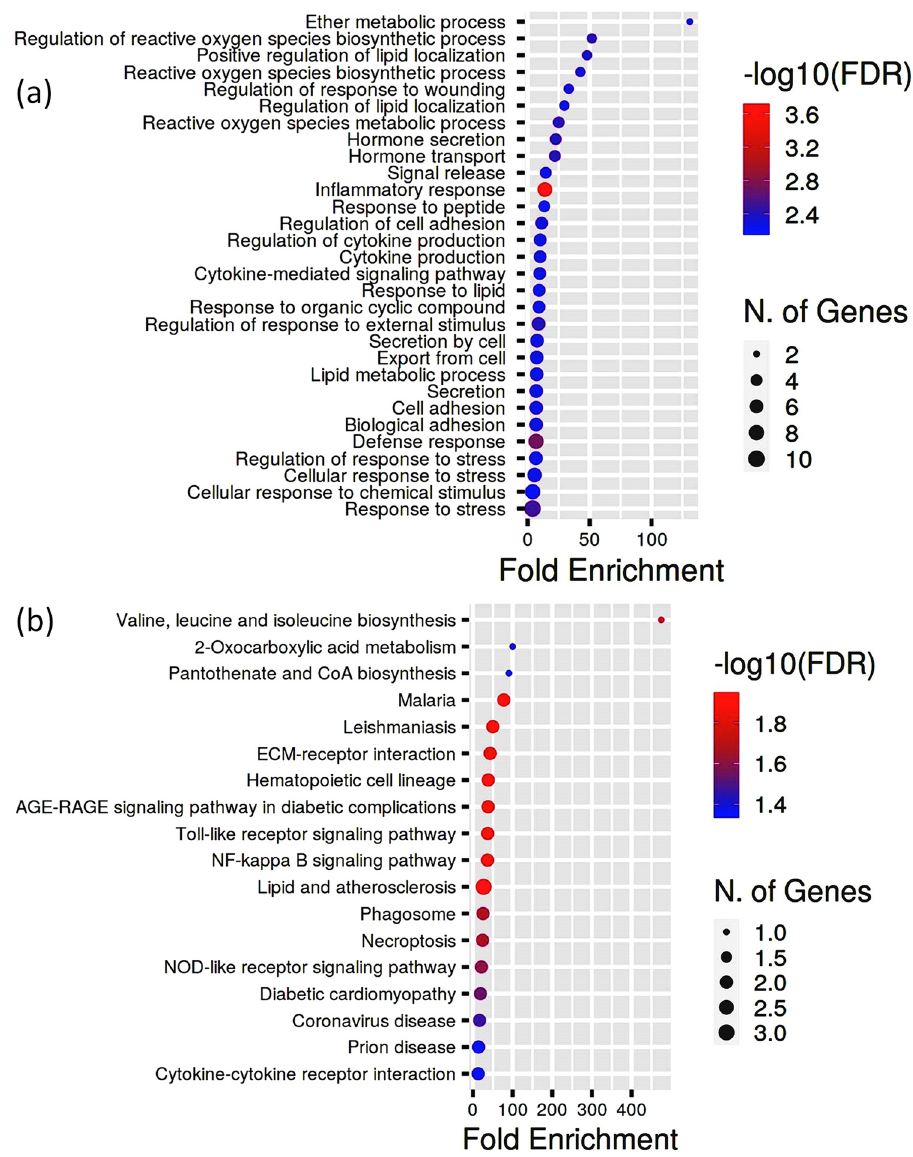
Figure 12: GO enrichment analysis by biological processes ( a ) and KEGG pathways ( b ) for common upregulated DEGs from GSE5058, GSE11784, GSE11906, and GSE100927 datasets. Biological processes and KEGG pathways are ranked according to fold enrichment values. The most signi fi cant processes are highlighted in red, and the less signi fi cant processes are highlighted in blue according to log10 ( FDR ) values. Larger dots in the graph indicate a greater number of genes